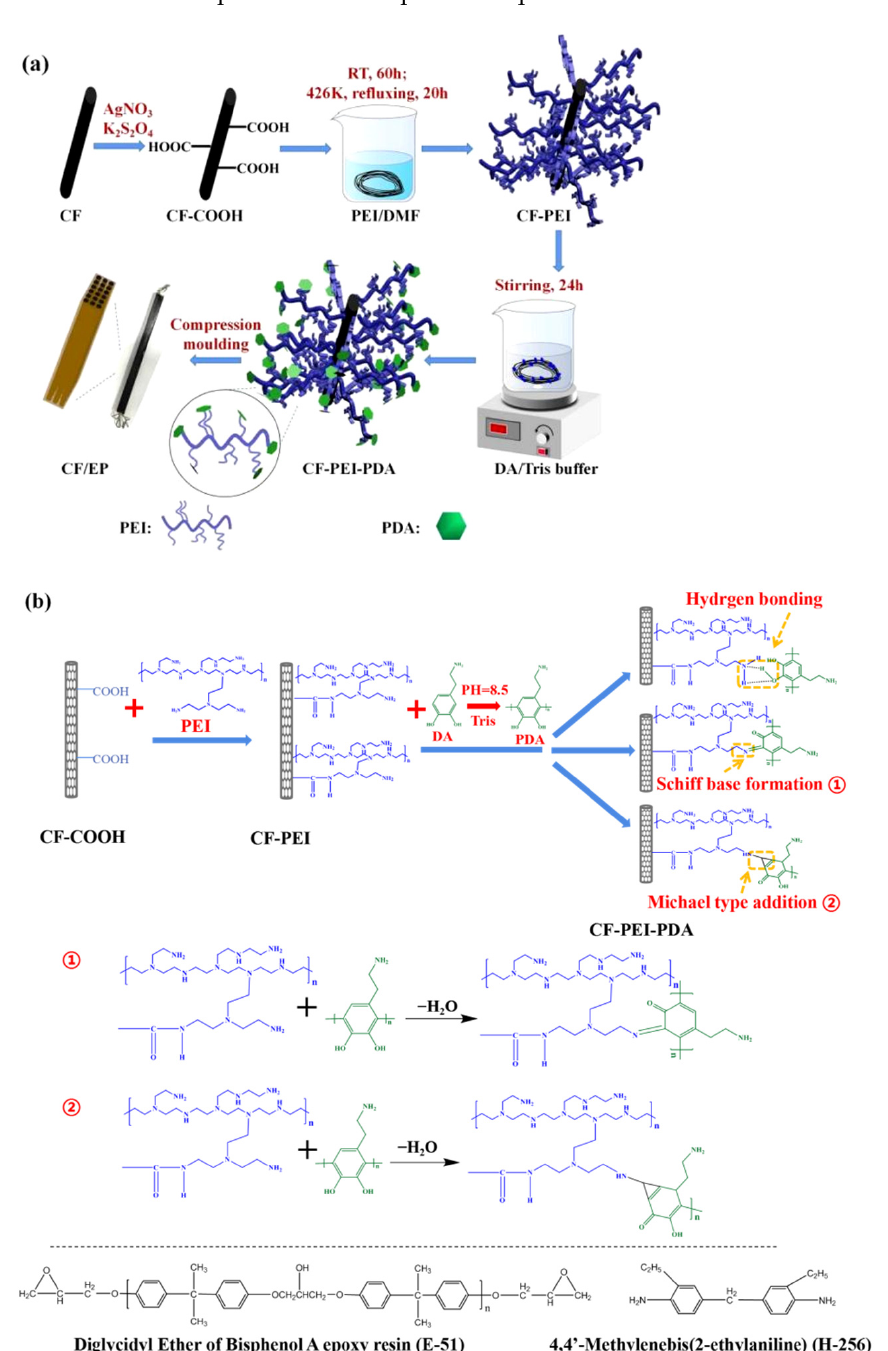
Figure 1. ( a ) Schematic illustration of preparation CF-PEI-PDA and ( b ) main interaction mechanism between CF-PEI and PDA.